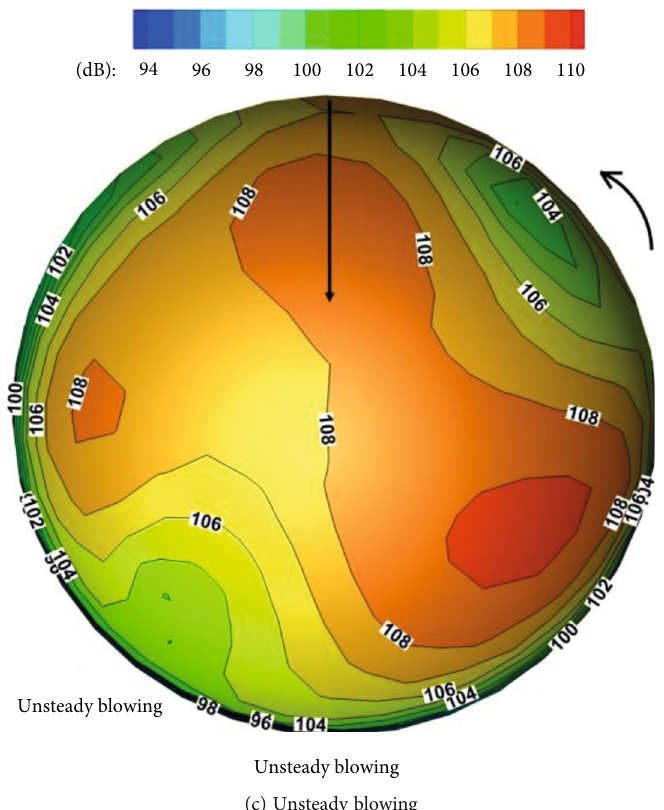
Figure 15: SPL contours on a hemispherical surface (3.44 R from the rotor hub) for steady/unsteady blowing